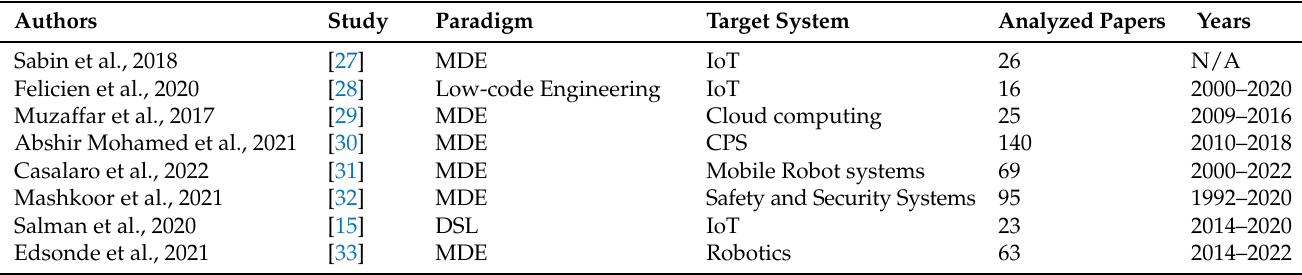
Table 1. Related